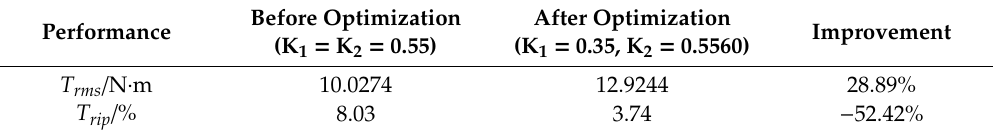
Table 5. The e ff ect of parameter